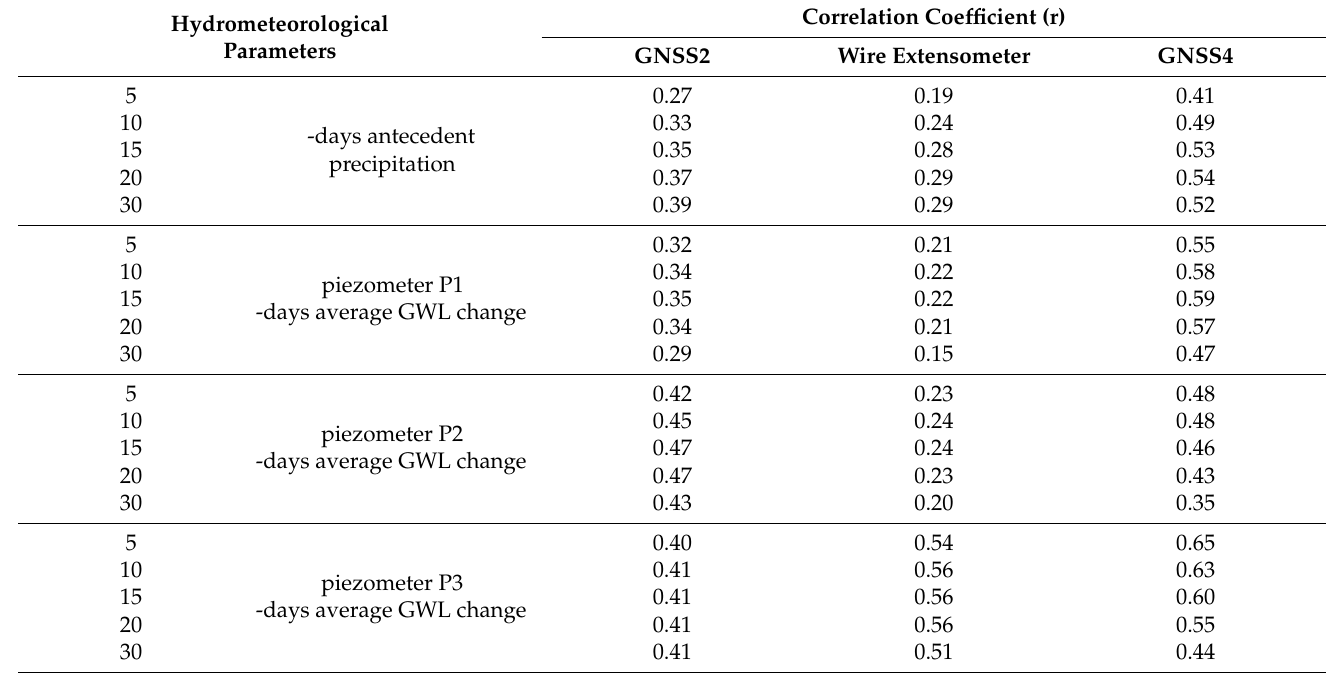
Table 3. Pearson correlation coefficient (r) between daily surface displacements and hydrometeoro- logical